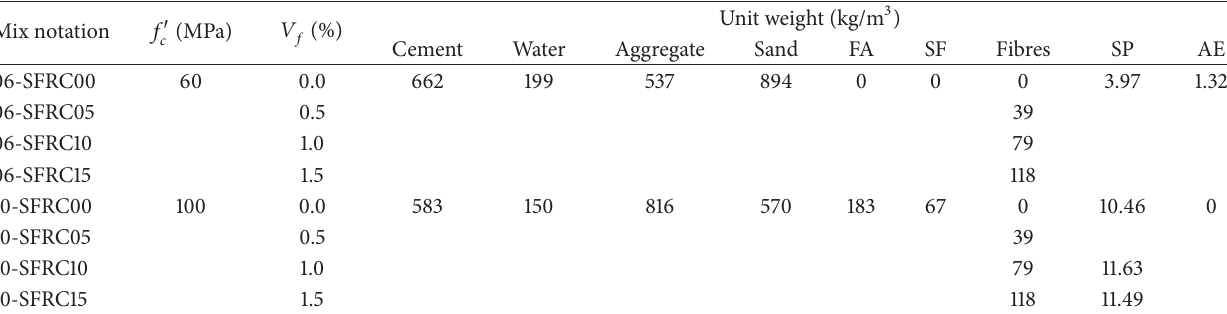
Table 1: Mixture proportions of HPCs used in the study.